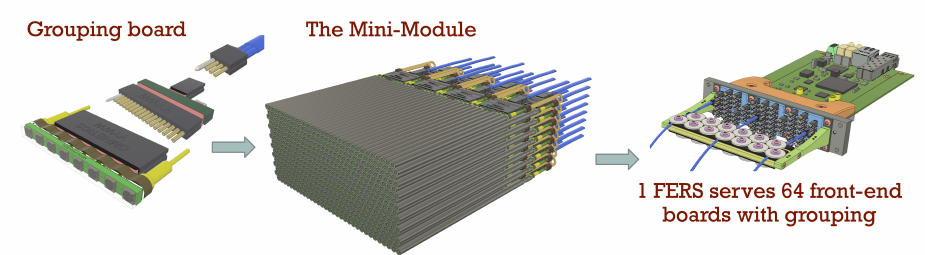
Figure 8. The main components designed for the next generation of prototype are shown. The PCB board equipped with 8 SiPM and the grouping board is shown on the ( left ). The grouping board is used to sum the analogue signals produced by 8 SiPMs with the goal of reducing the number of channels to be read out. The mini-module is shown in the ( middle ) and the new design should allow to connect the SiPMs directly to the capillaries avoiding light contamination. The new patch panel, where the 512 SiPMs from the mini-module (64 signals after the grouping) are interfaced to one A5202 board, is shown on the ( right